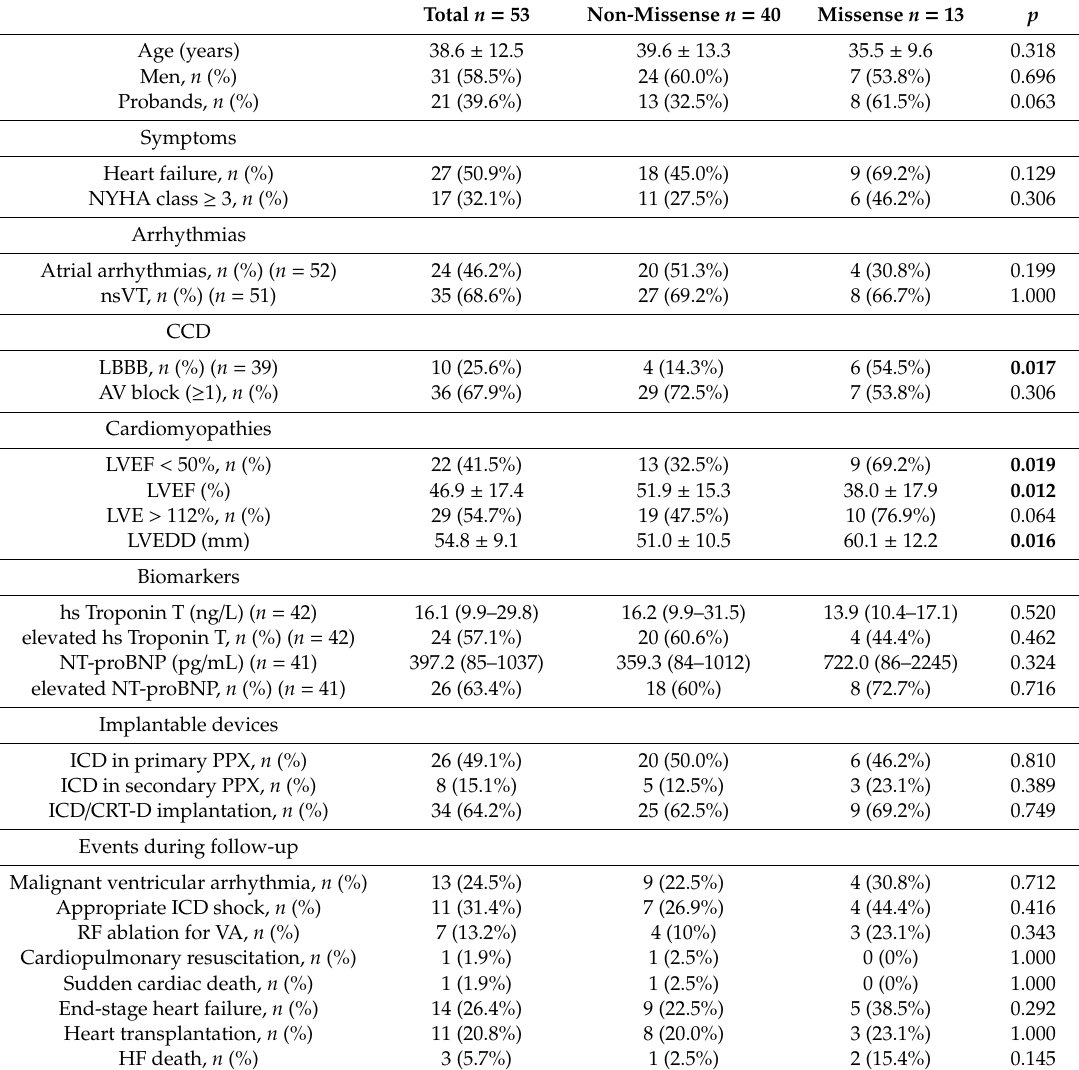
Table 4. Clinical Characteristics of LMNA variant carriers at last